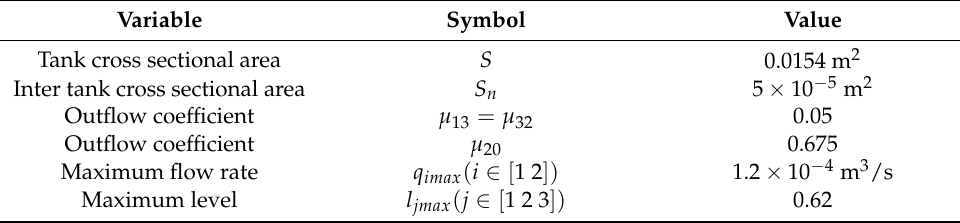
Table 5. Parameters value of the three-tank